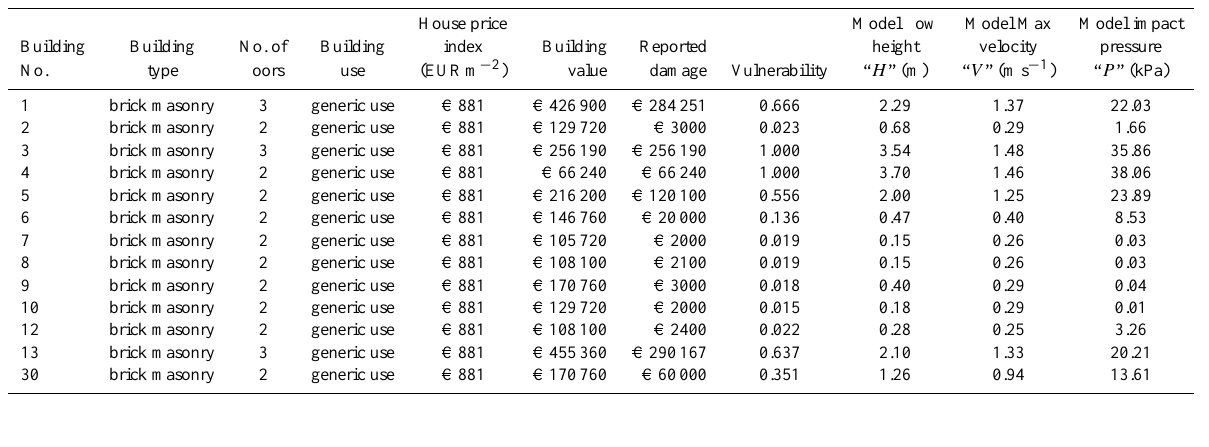
Table 1. Values used for the vulnerability functions assessment.